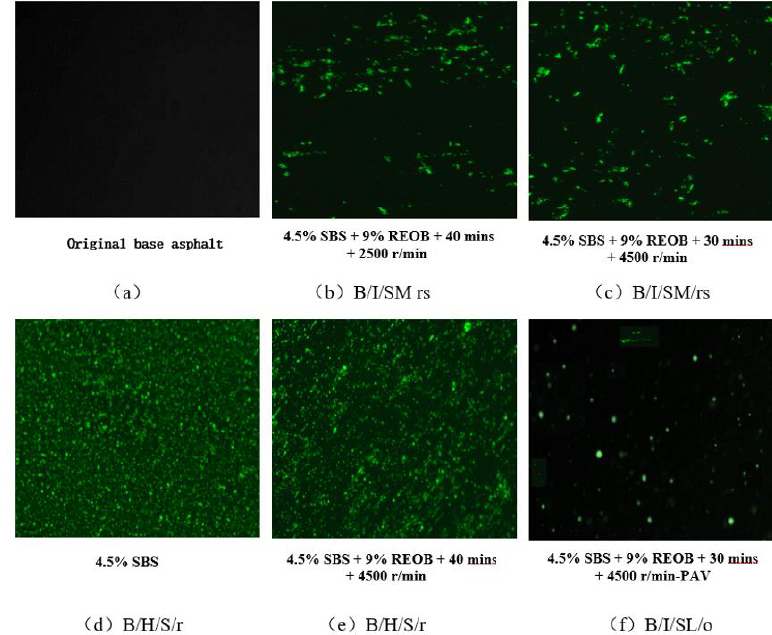
Figure 7. Fluorescence microstructure images of different asphalt samples.